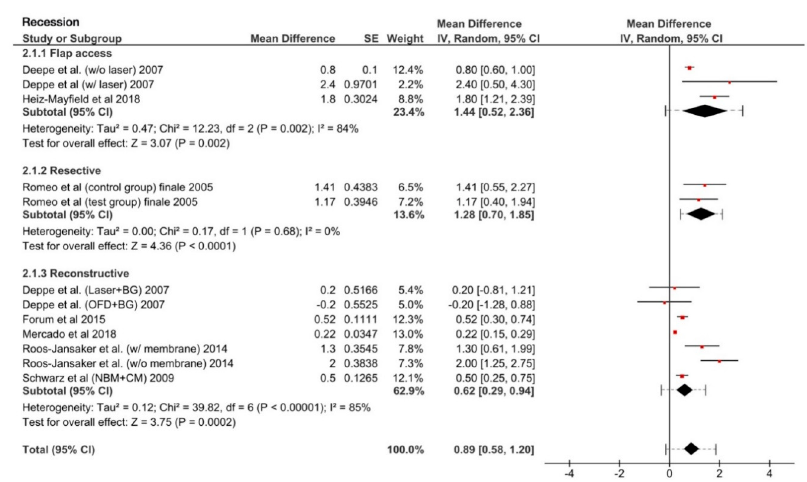
Figure 4. Recession increase after treatment of peri-implantitis following flap access, resective or reconstructive approaches. Mean recession increase in each study is reported by a red dot. The 95% confidence intervals are indicated with horizontal lines intersecting the mean recession. The estimate average and confidence interval of all the individual studies are reported with black diamonds. Prediction intervals are reported as dotted lines intersecting the diamonds. A diamond on the right of the line of null effect indicates recession increase and a diamond on the left of the line of null effect indicates recession reduction. Abbreviations. BG: bone grafting, CM: collagen membrane, OFD: open flap debridement, SLA: sandblasted acid-etched surface, TPS: titanium plasma-sprayed surface. Appl. Sci. 2019 , 9 , x FOR PEER REVIEW